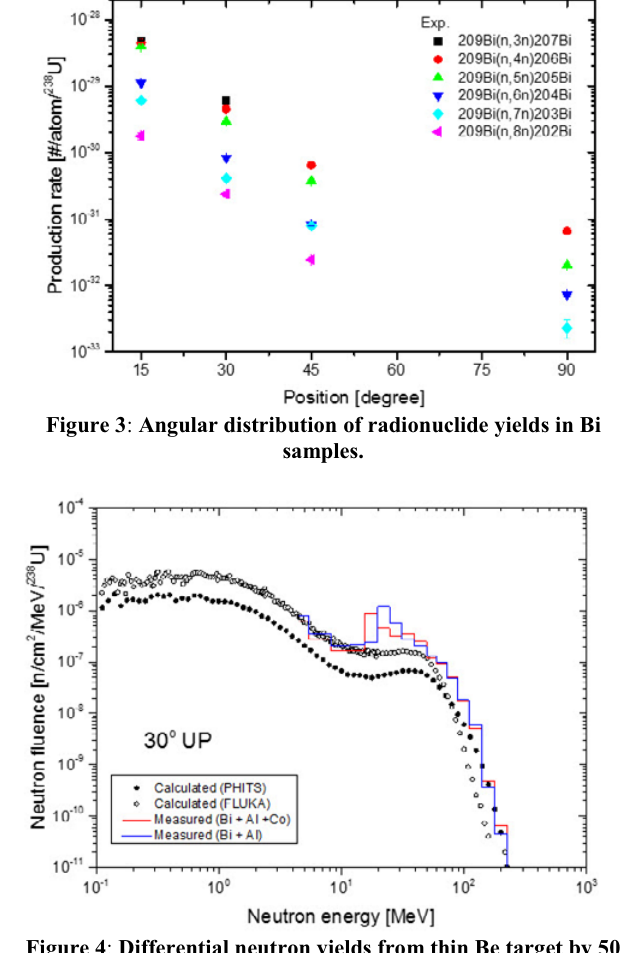
Figure 4 : Differential neutron yields from thin Be target by 50 Mev/u 238 U beam at 30 degree: comparison of the measured using two or three elements with resulted calculated by PHITS and